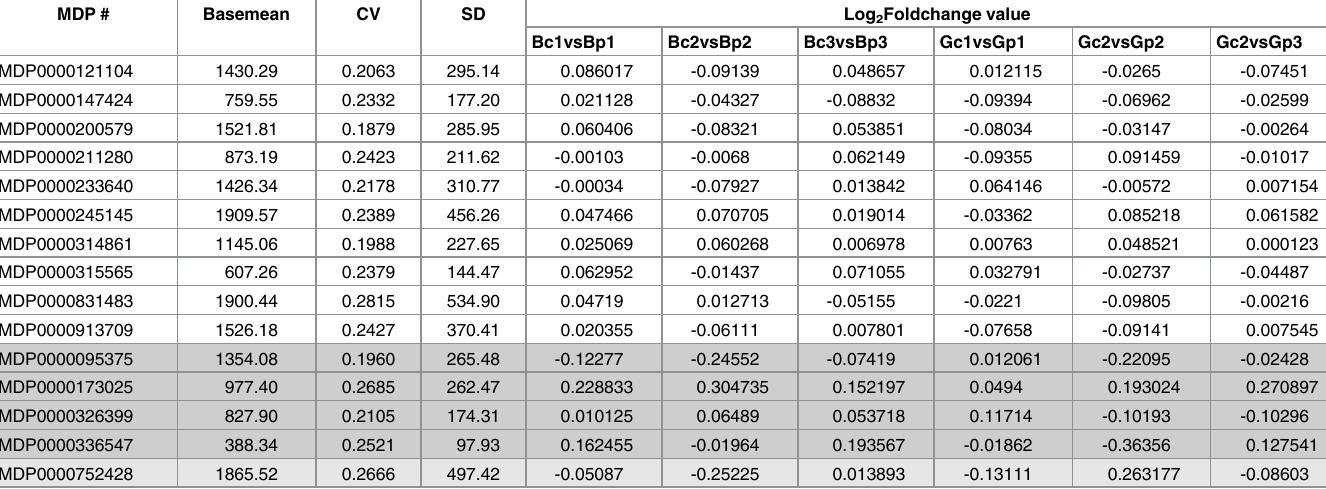
Table 1. Evaluation of selected referencegenes using RNA-Seq